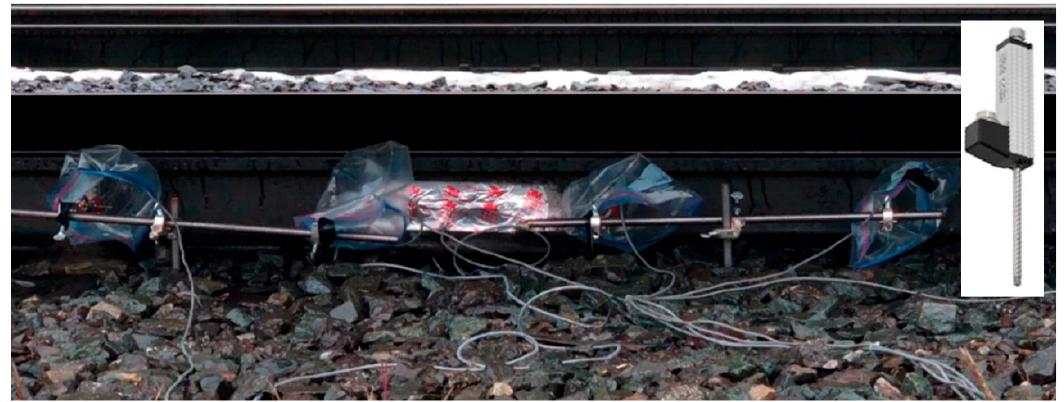
Figure 7. The linear potentiometer and rod system used to measure the vertical track displacement.